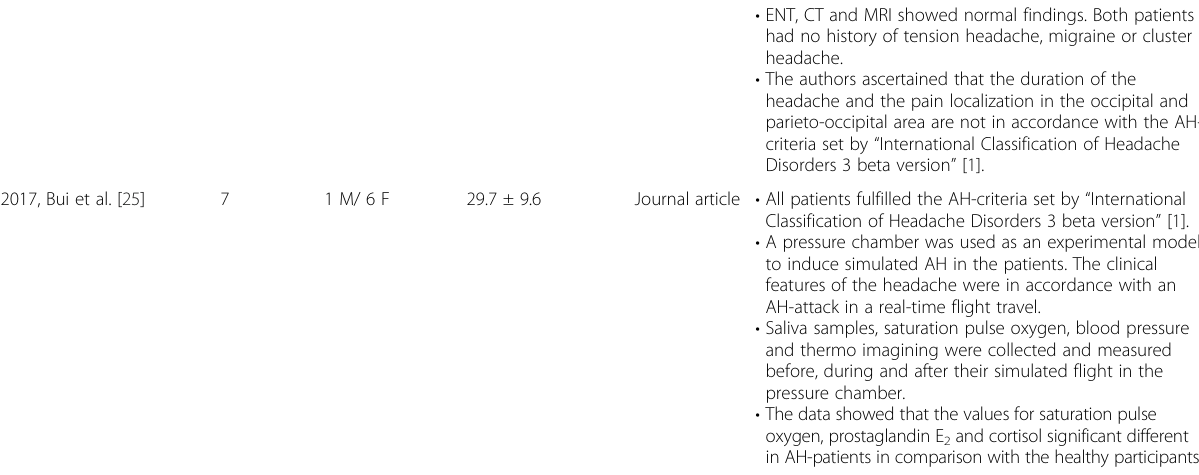
Table 1 Demographic characteristics and main outcomes of the current literature regarding headache attributed to airplane travel (Continued)